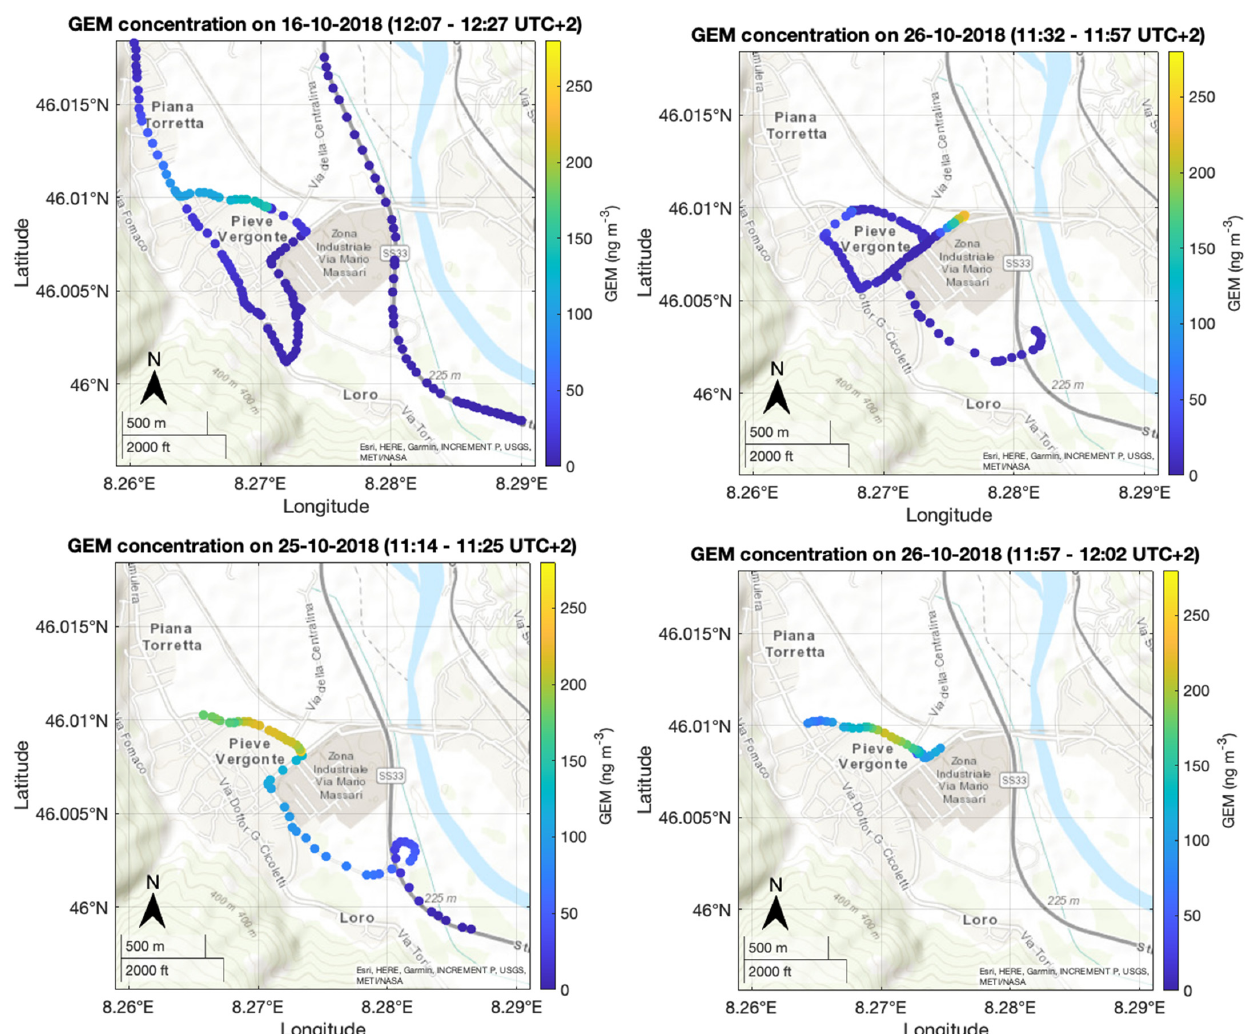
Figure 4. GEM concentrations measured during four car surveys around the industrial area in Pieve Vergonte.